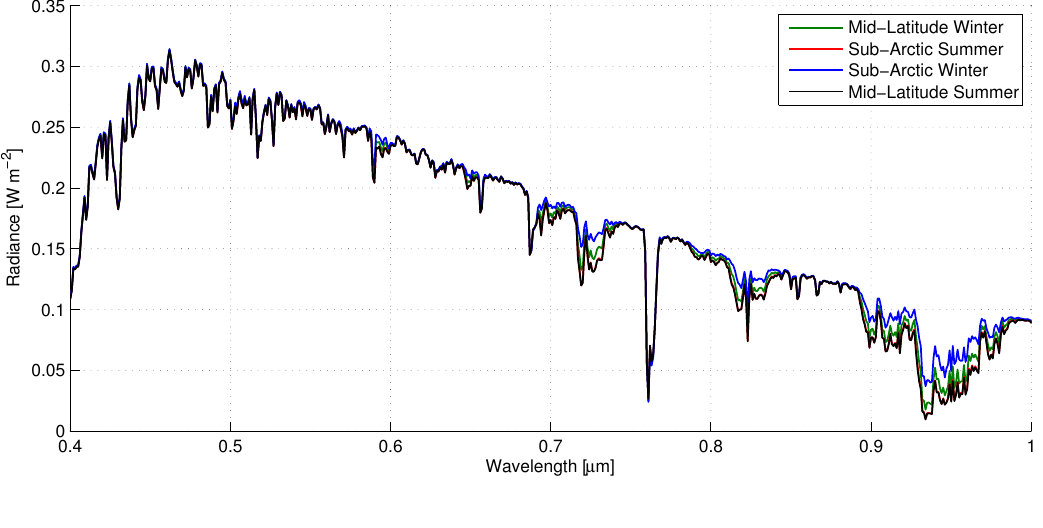
Figure 4. Radiance simulations using MODTRAN-5 with constant water vapour values and different atmospheric profiles.